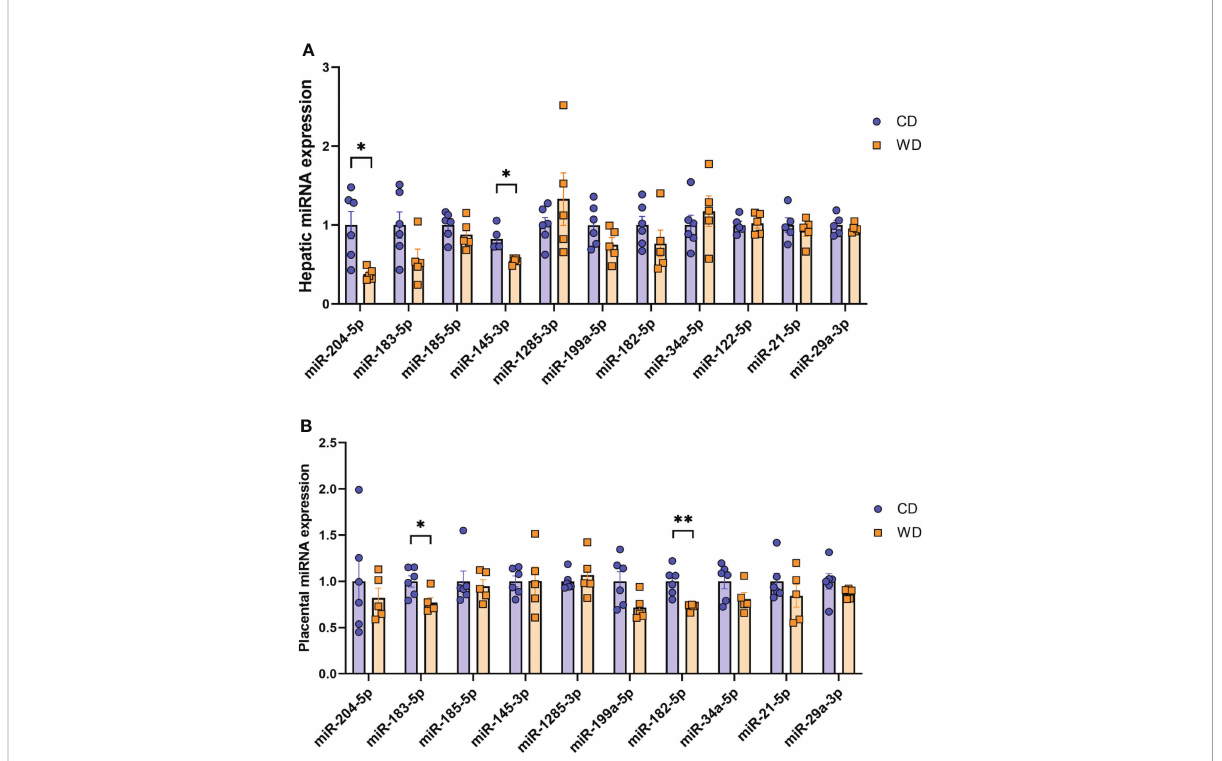
FIGURE 5 MicroRNA expression analysis. Expression of miRNAs in mCD- and mWD-exposed fetal liver (A) and placental tissue (B) . n = 6 CD and n = 5 WD. Unpaired 2-tailed Student ’ s t test was used to test signi fi cance. * P < 0.05, ** P <